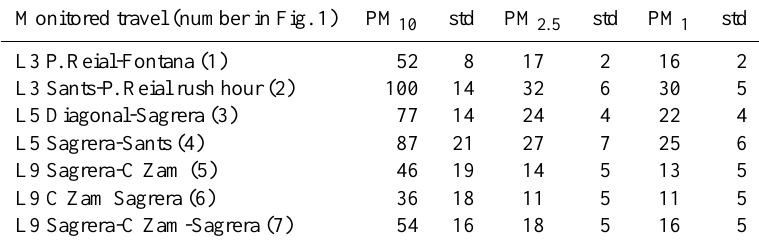
Table 3. PM x levels and standard deviation (std) of minute values (µgm − 3 ) measured inside trains during different journeys across lines 9, 5 and 3. Numbers in brackets refer to trips marked in Fig.